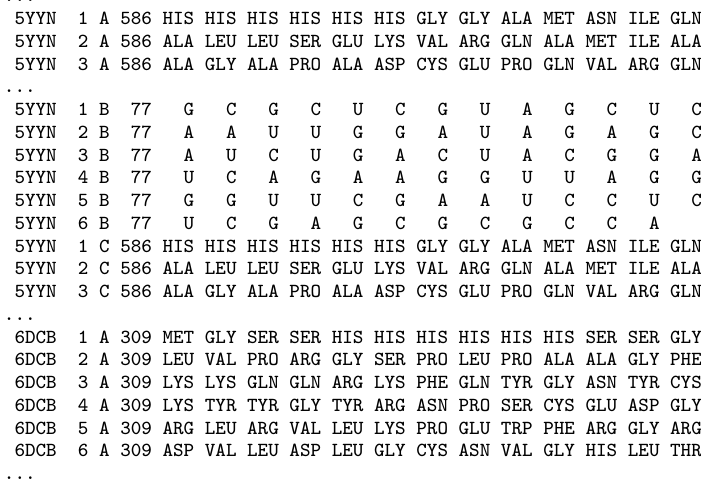
Figure 3. Results of the extraction of the SEQRES section performed with the U-SQL script from Listing 2 showing a part of produced rowset.